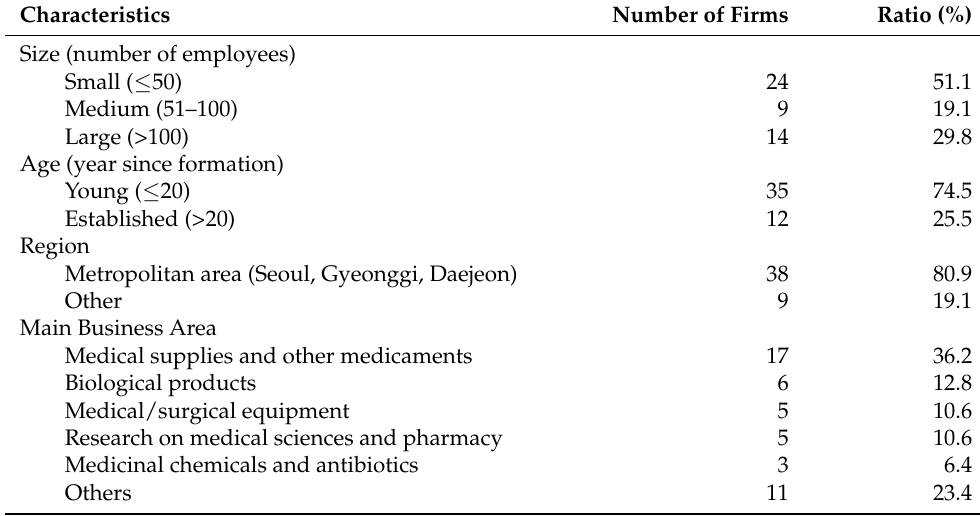
Table 1. General characteristics of the sample firms.